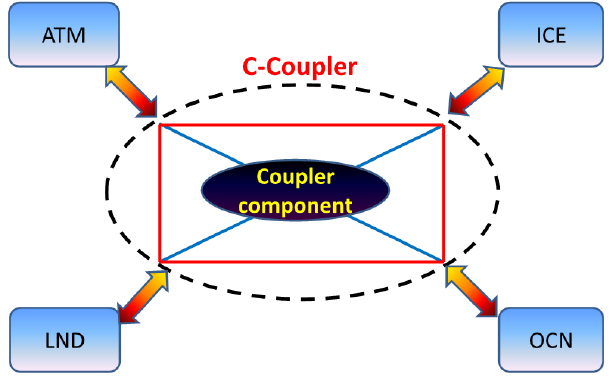
Figure 1. The architecture of the models with Fig. 1. The architecture of the models with the C-Coupler. 2